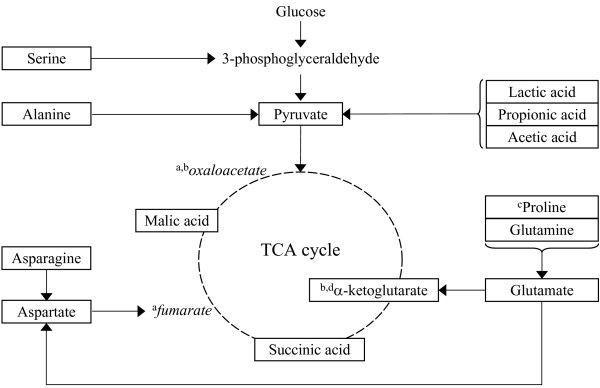
Key carbon sources that were not metabolized by the E. coli O157:H7 hns mutant. Some of the metabolic intermediates and substrates that were not (□, open box) metabolized as sole carbon sources by the hns mutant of E. coli O157:H7 when examined using Phenotypic Microarrays. Both the parent and hns mutant strains metabolized the compounds that are not in boxes. Compounds in italics which were not tested (a). E. coli converts glutamate and oxaloacetate to α-ketoglutarate and aspartate (b) [55,56]. Glycyl-L-proline was tested (c). α-ketoglutarate was not metabolized as a sole carbon source by neither the parent strain nor the hns mutant (d).